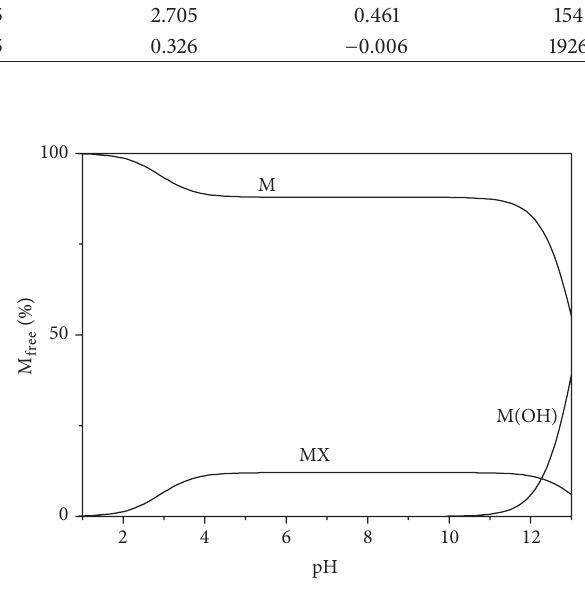
Figure 1: Distribution diagram of species of cation “M” of synthetic saliva versus pH, at 𝑡 = 37 ∘ C, according to S 3 M.